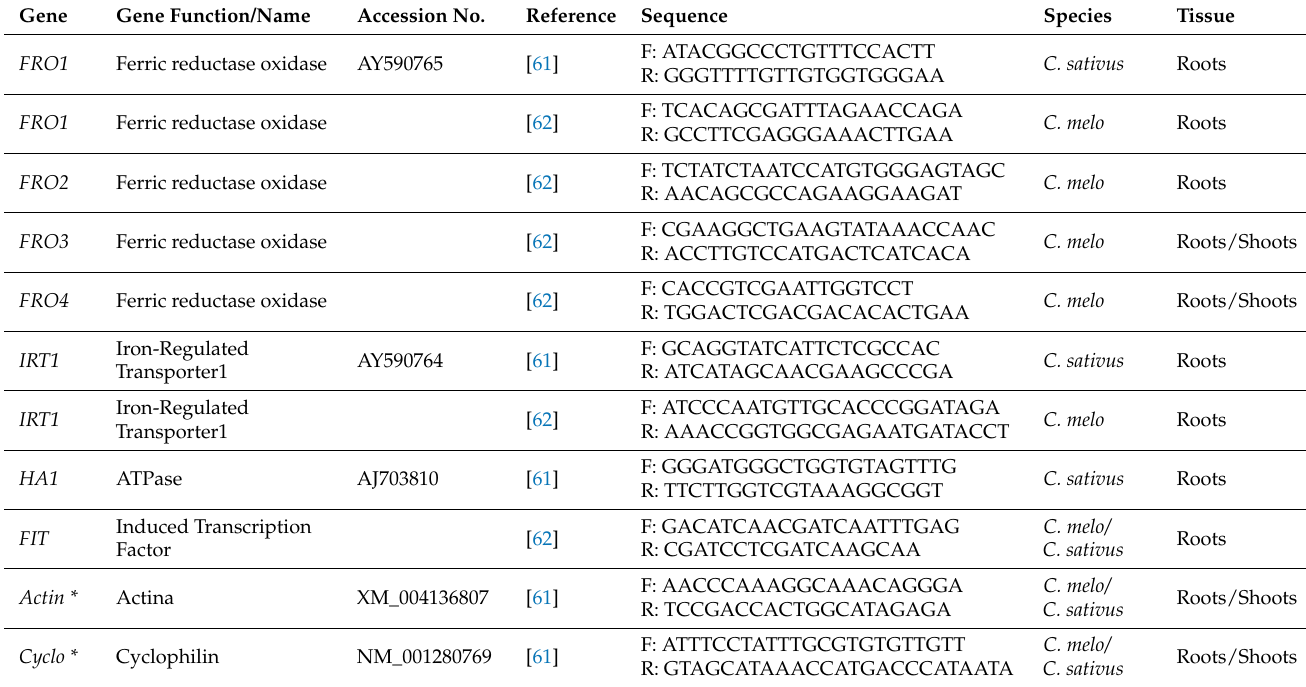
Table 2. Primers used in qRT-PCR